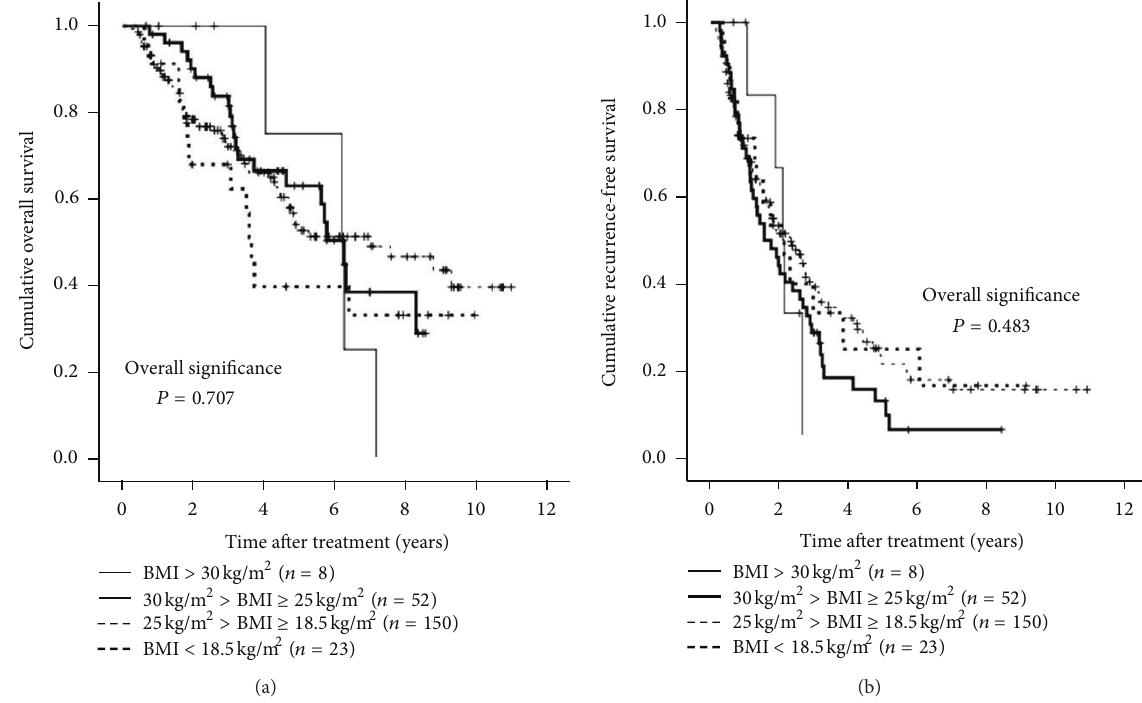
Figure 8: The Kaplan-Meier curves using classification into four groups according to BMI (BMI ≥ 30 kg/m 2 ( 𝑛 = 8 ), 30kg/m 2 > BMI ≥ 25 kg/m 2 ( 𝑛 = 152 ), 25kg/m 2 > BMI ≥ 18.5 kg/m 2 ( 𝑛 = 150 ), and BMI < 18.5 kg/m 2 ( 𝑛 = 23 )). In terms of overall survival ( 𝑃 = 0.707 ) and recurrence-free survival ( 𝑃 = 0.483 ), the overall difference in these four groups did not reach significance ((a) and